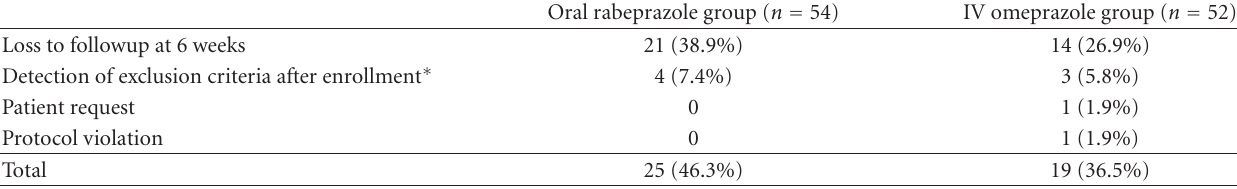
Table 4: Number (%) of patients who discontinued the study grouped by primary reason (ITT